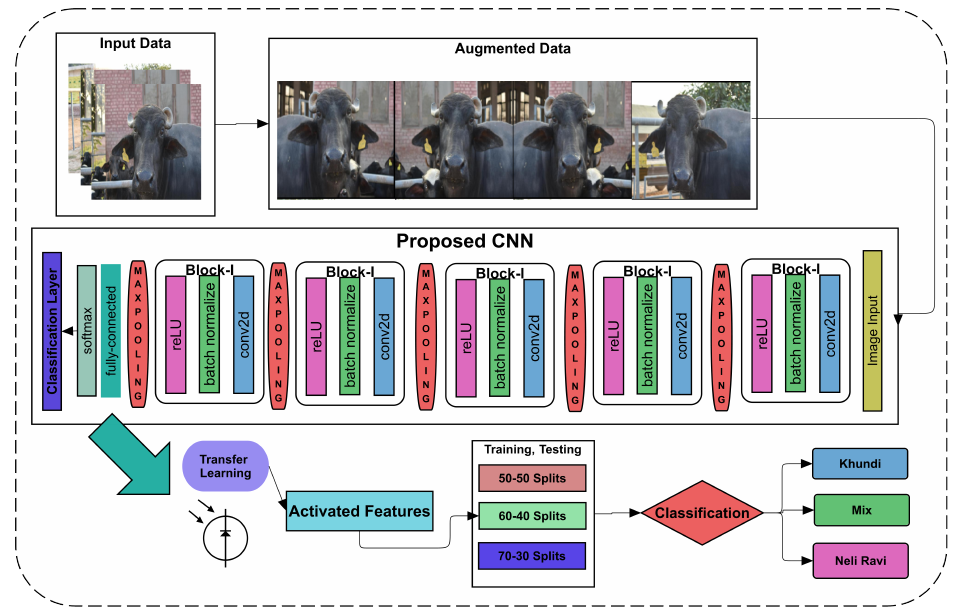
Figure 1. Proposed framework used to identify and segregate Neli-Ravi breed from all other breeds.